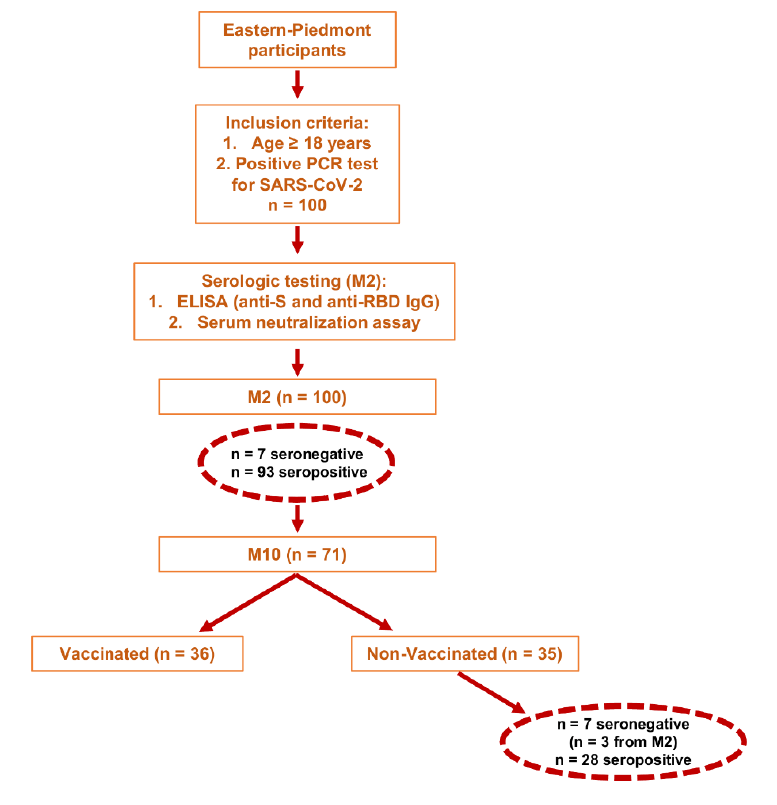
Figure 1. Study design and participants.